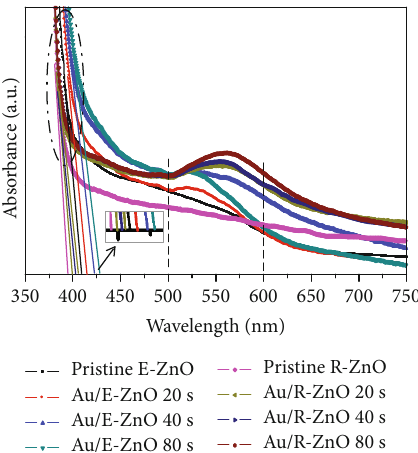
Figure 5: UV-vis di ff use re fl ectance spectra of pristine E-ZnO, pristine R-ZnO, Au/E-ZnO, and Au/R-ZnO heterojunction nanocomposites for di ff erent Au NP deposition times (20 s, 40s, and 80s), respectively. The inset is an enlarged view of absorption edges for pristine ZnO and Au/ZnO with di ff erent Au NP deposition times (20 s, 40 s, and 80s), respectively.